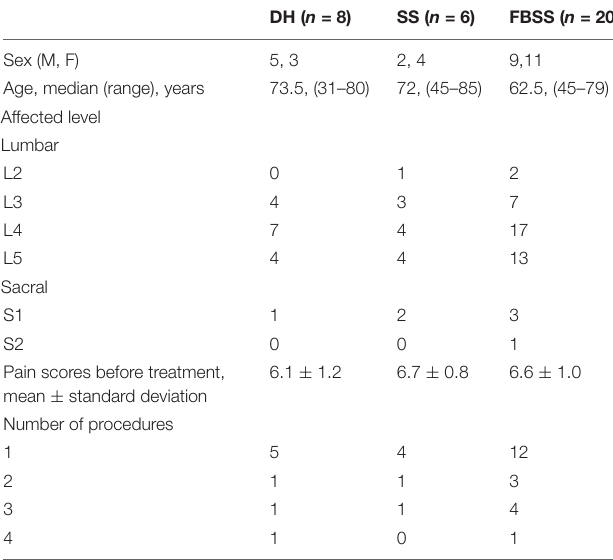
TABLE 1 | General demographics of participants.